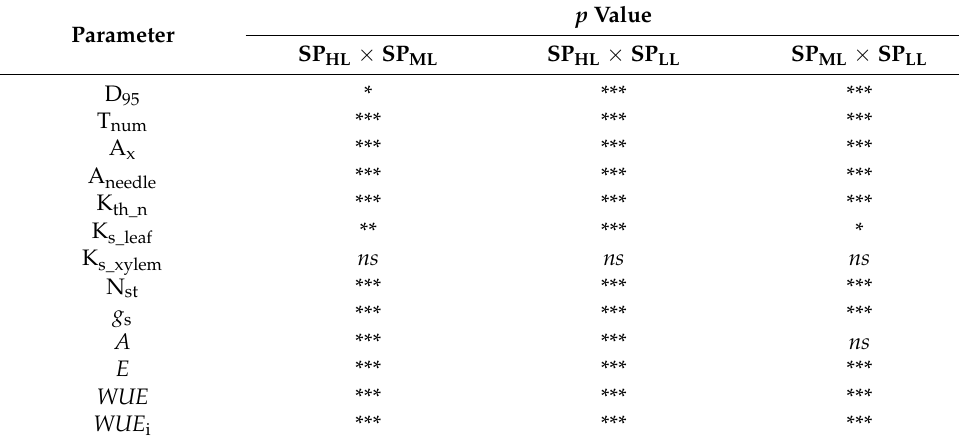
Table 1. p values from the Tukey’s honest significant difference (HSD) test showing the probability of differences in the needle xylem traits and leaf gas exchange parameters between the clear-cut SP HL and shading in the clear-cut SP ML or the forest SP LL and between SP ML and SP LL . p Value Parameter SP HL × SP